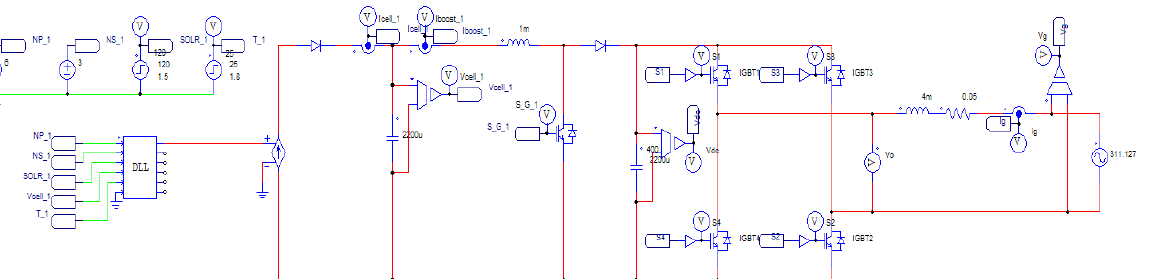
Figure 12. Simulation diagram.